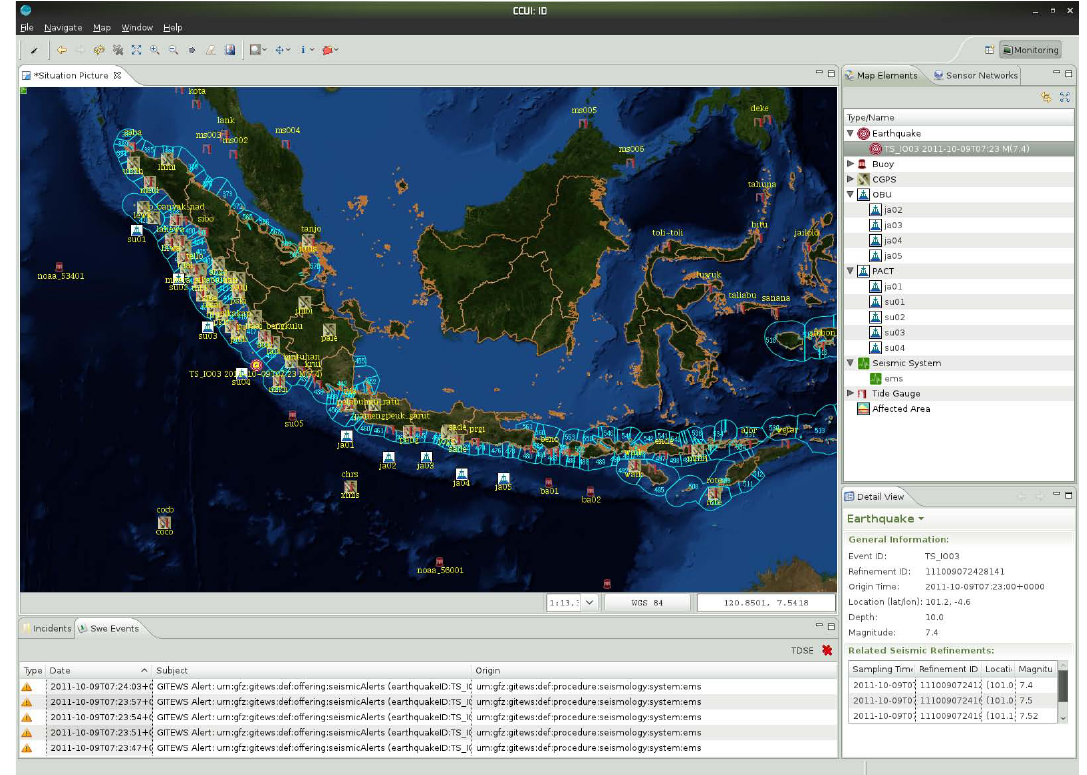
Fig. 6. Monitoring